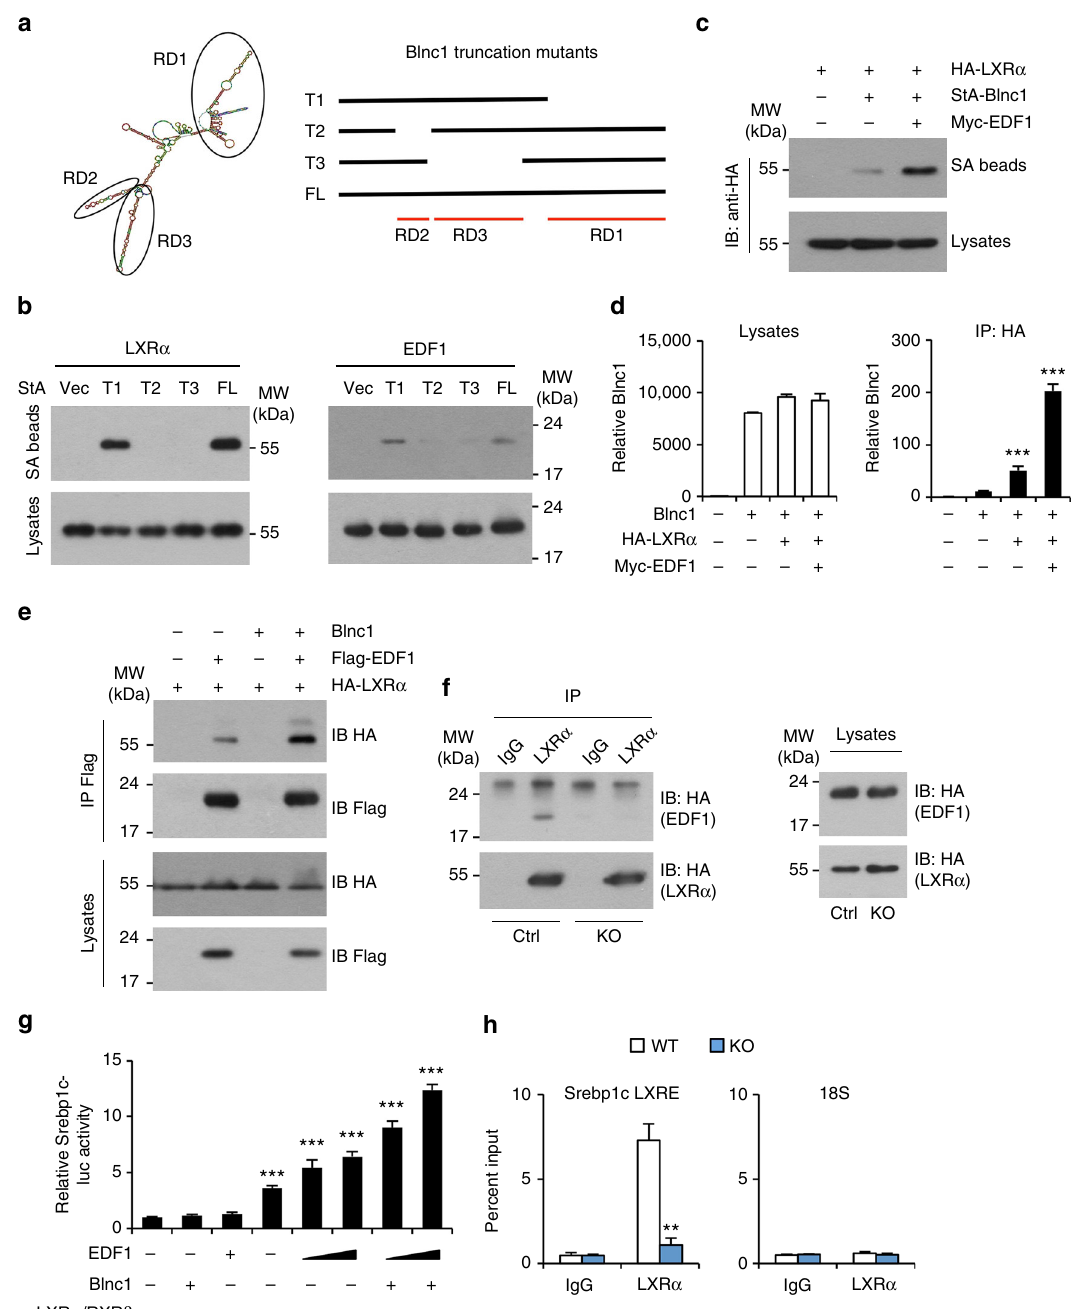
Fig. 9 Physical and functional interaction between Blnc1, LXR α , and EDF1. a Diagram of Blnc1 RNA domains (RD, left) and truncation mutants (right). b , c Immunoblots of total lysates and streptavidin (SA) beads precipitated proteins from transiently transfected HEK293T cells. d IP/qPCR analyses of Blnc1 in α -HA immunocomplexes (right) and input (left) from transiently transfected HEK293T cells. e Immunoblots of total lysates and α -Flag immunocomplexes from transiently transfected HEK293T cells. f Immunoblots of total lysates and α -LXR α immunocomplexes from WT and Blnc1 KO hepatocyte transduced with HA-LXR α and HA-EDF1 adenoviruses. g Srebp1c -luciferase reporter assay. Data in ( d ) and ( g ) represent mean ± SD ( n = 3). *** p < 0.001, vs. vector, one-way ANOVA. h ChIP assay of LXR α occupancy in the livers from WT (open) and KO ( fi lled) mice gavaged with T1317 for 4 days. Data represent mean ± SD ( n = 3). ** p < 0.01, two-tailed unpaired Student ’ s t differential expression analysis 46 . Gene enrichment analysis was performed using hepatocytes using a hexane-isopropanol mixture (hexane: isopropanol DAVID (david.abcc.ncifcrf.gov). (v: v) = 3:2) and resuspended in toluene following solvent evaporation. Radio- activity was quantitatively measured using a scintillation counter. In vitro lipogenesis assay . Primary hepatocytes were transduced with recombi- RNA-protein interaction assays . RNA-protein interaction studies were per- nant adenoviruses for 24 h followed by treatment with DMSO or T0901317 for additional 24 h. For lipogenic assay, treated hepatocytes were incubated with Krebs formed as previously described 20 . Brie fl y, for IP/qPCR assay, HEK293T cells Ringer buffer supplemented with 0.1% fatty acid free-BSA in the presence of 0.2 transiently transfected with HA-EDF1 or HA-LXR α and Blnc1 alone or in com- μ Ci/mL C 14 -acetate and incubated for 2h. Total lipids were extracted from treated binations. Immunoprecipitation was performed using anti-HA agarose beads. After